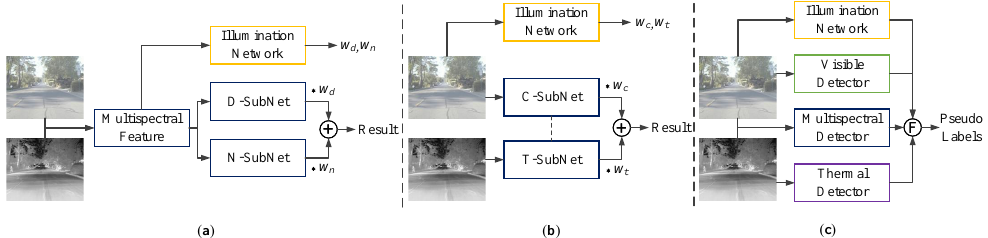
Figure 6. Illustration of the difference between existing illumination-aware weighting mechanisms and our illumination estimation network for pseudo label fusion. ( a , b ) are the illumination-aware weighting mechanisms proposed in [18,43] for supervised training respectively, where w represents the illumination weight and + indicates the operation of matrix addition. The final result contains both the confidence score and predicted bounding box, calculated as the weight sum of corresponding items from two modalities respectively. ( c ) illustrates our illumination-aware label fusion mechanism, where F indicates the pseudo label fusion